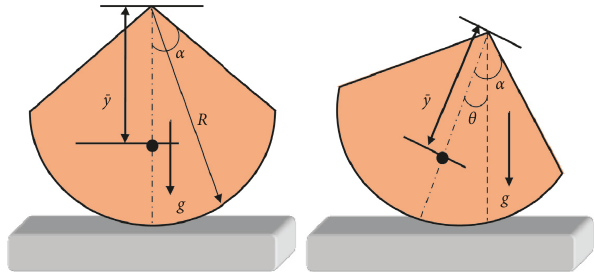
Figure 1: Geometric interpretation of a homogenous circular sector object over a solid